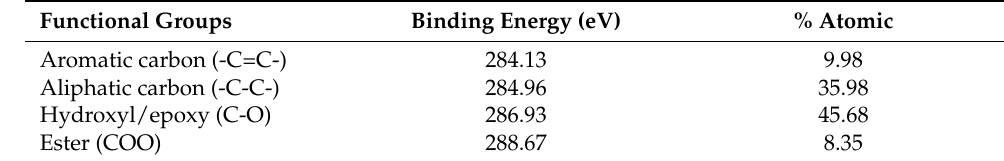
Table 1. Analysis of C1s scan by XPS showing the chemical groups in GO. Functional Groups Binding Energy